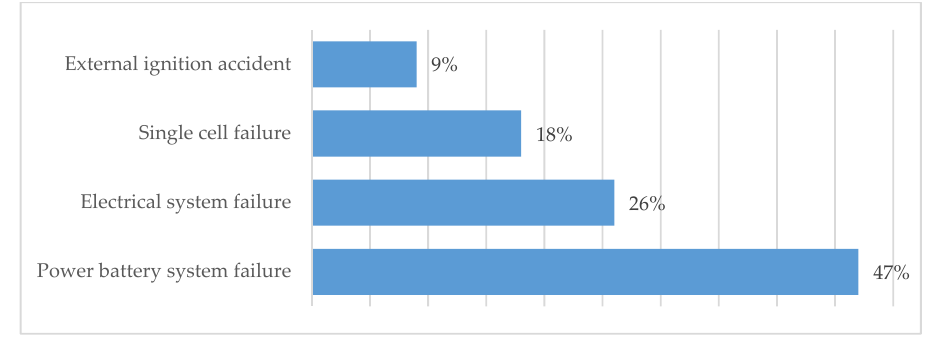
Figure 13. Distribution of the fire causes of NELVs in China.